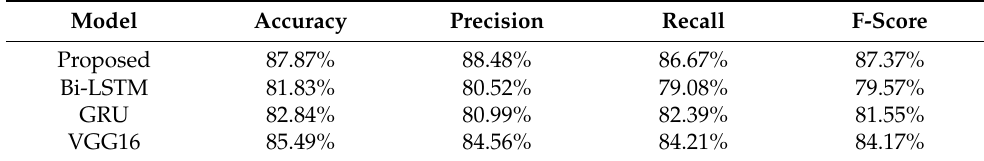
Table 2. Results